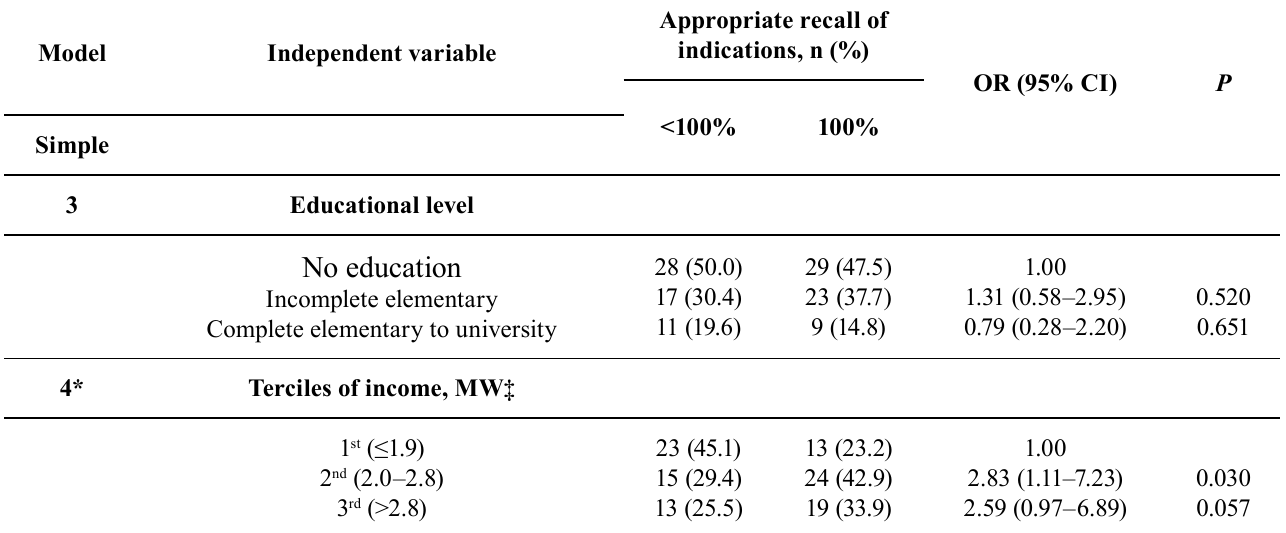
TABLE III – Simple and multiple logistic regression models predicting the appropriate recall of 100% of indications (N = 117)